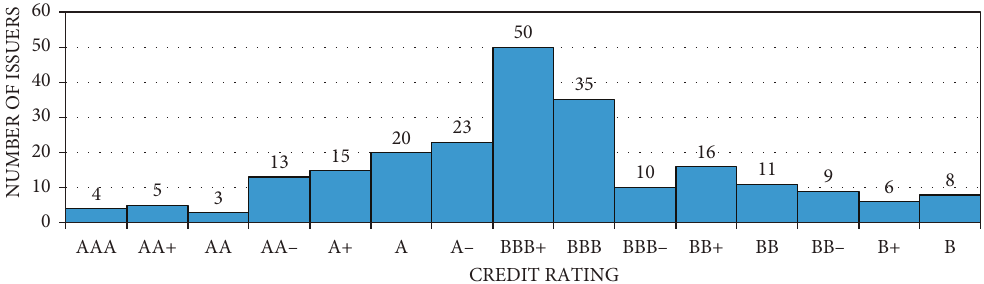
Figure 6: Crediting Rating of Green Bond Issuers in the US (Data source: Bloomberg, compiled by the